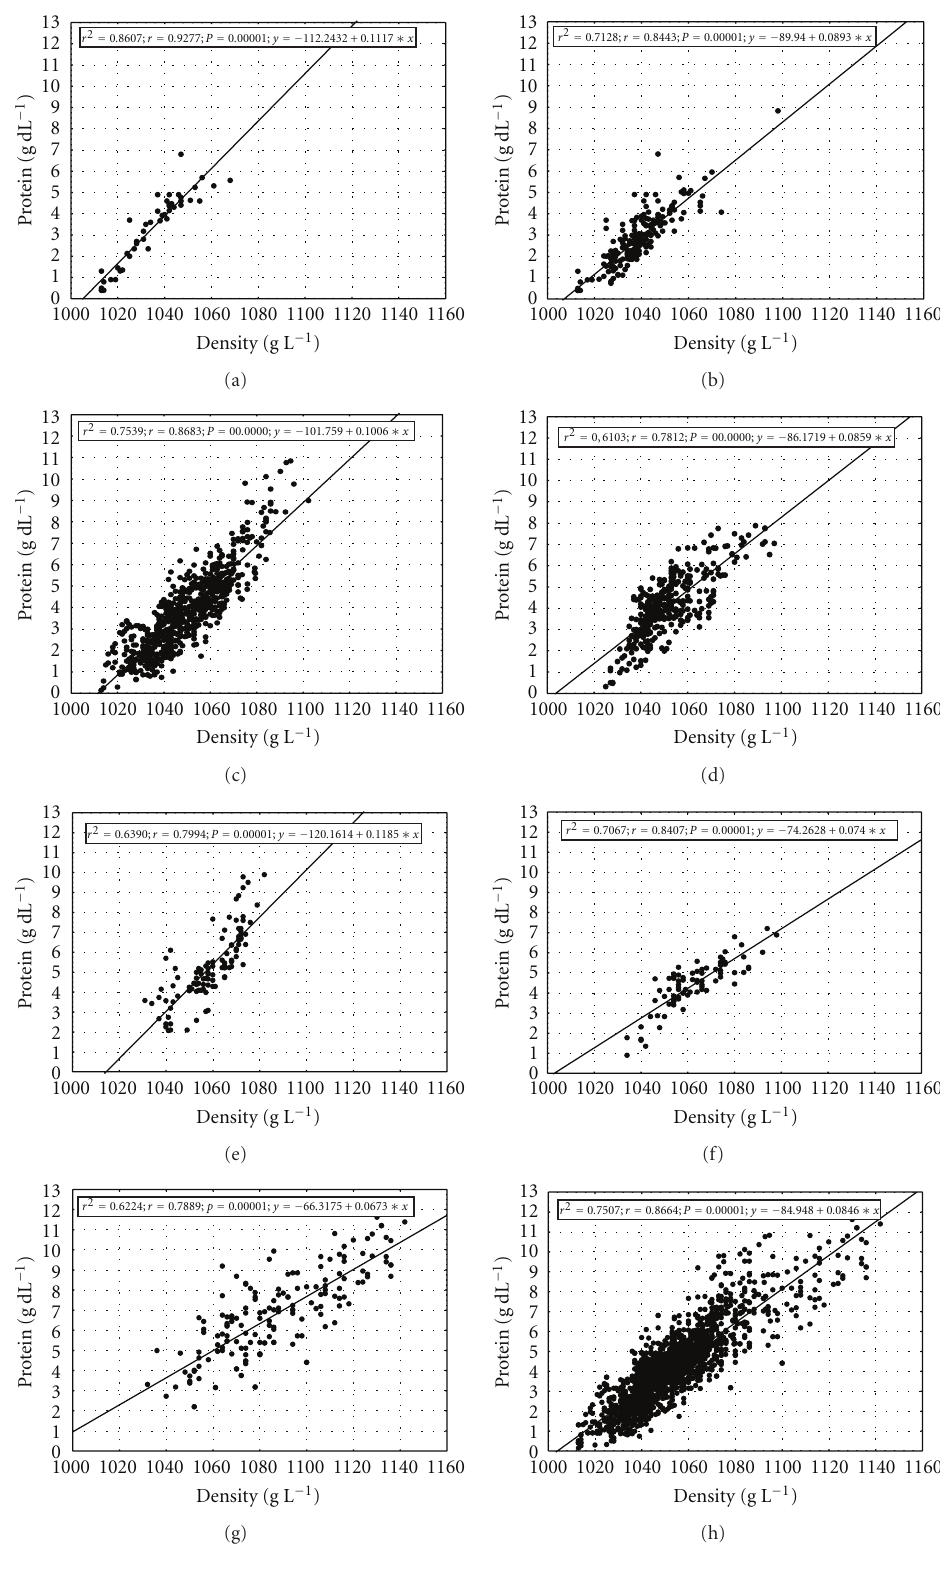
Figure 2: Correlation regression between total protein concentration and density of the hemolymph in: (a) A. leptodactylus n : 46; (b) S. manti s n : 191; (c) C. aestuarii n : 656; (d) H. americanus n : 325; (e) C. pagurus n : 114; (f) U. pusilla n : 79; (g) P. elegans n : 164; (h) All species plotted together n :